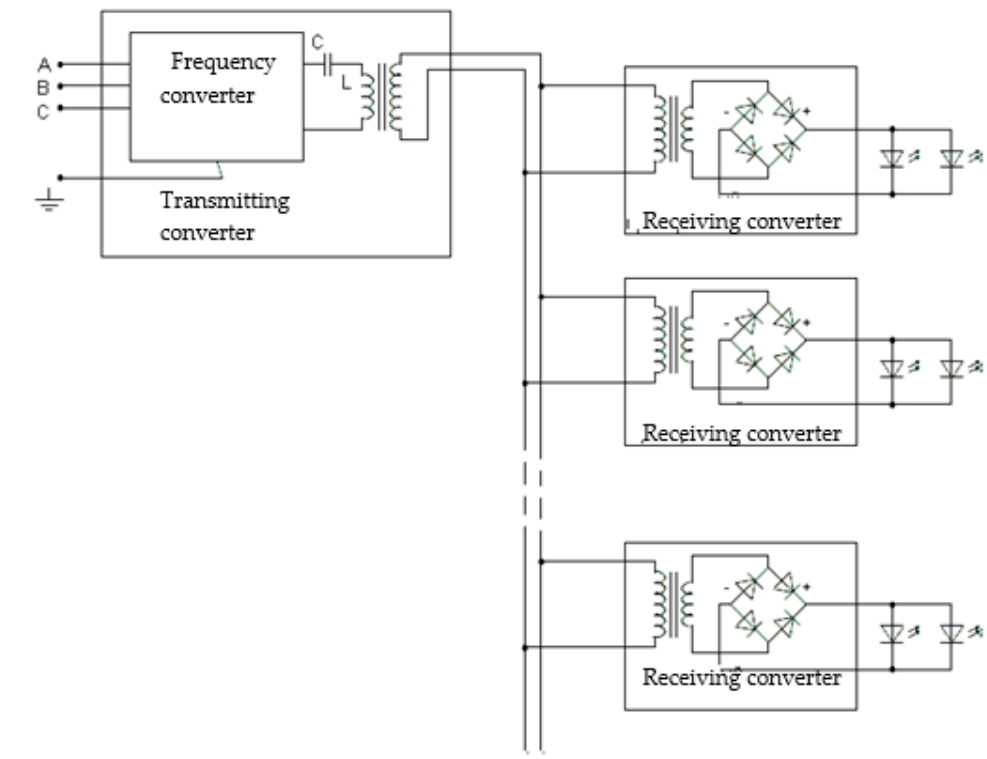
Figure 8. Resonant power supply system for LED lamps.